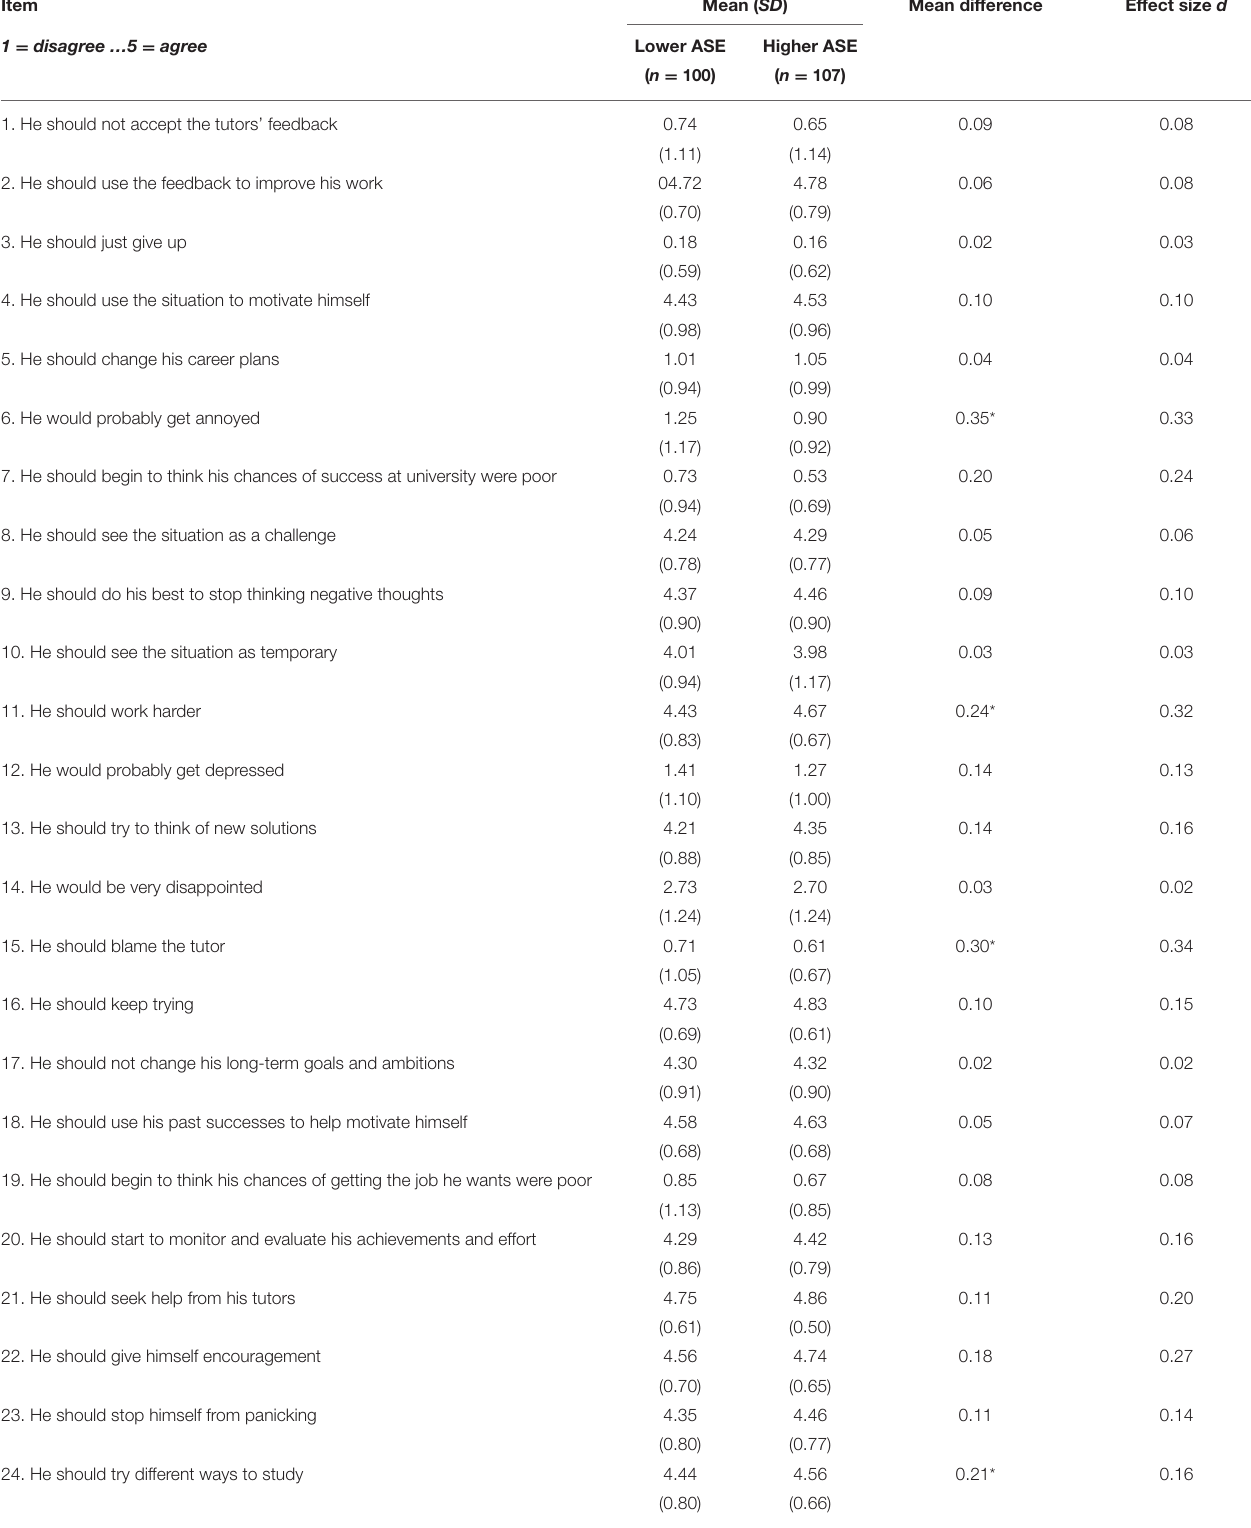
TABLE 6 | Academic resilience scale (vicarious vignette) item summary statistics by academic self-efficacy (ASE) group. Item Mean ( SD ) Mean difference Effect size